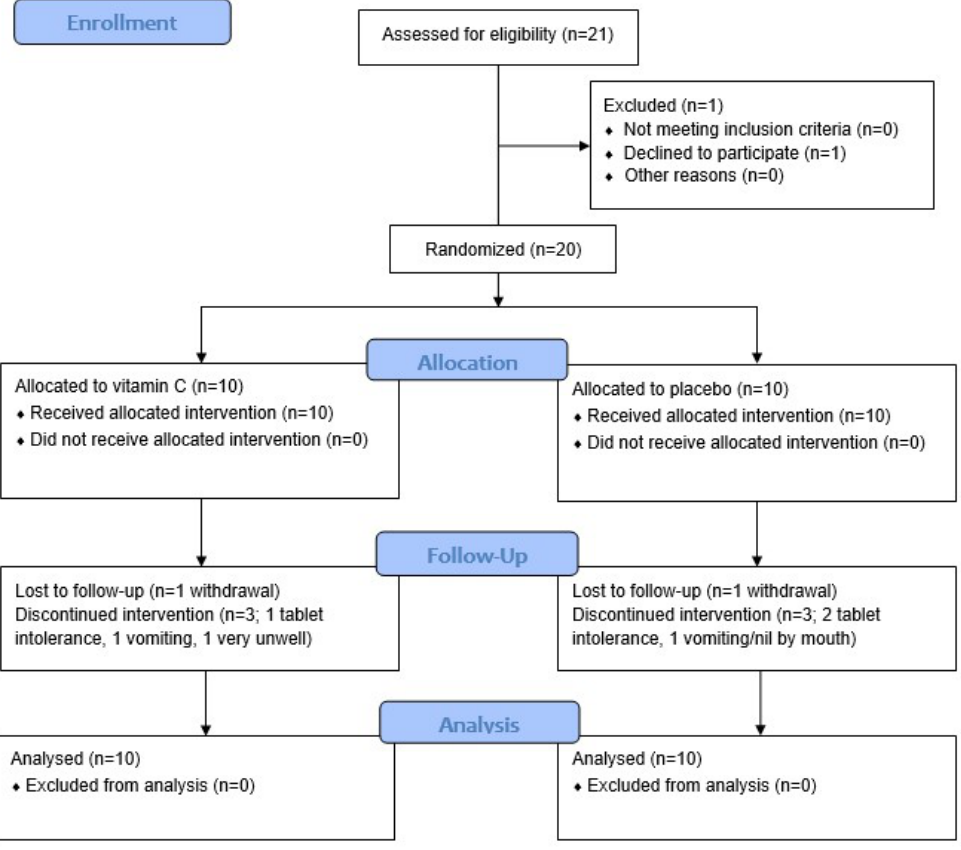
Figure 1. CONSORT Figure 1. CONSORT diagram.